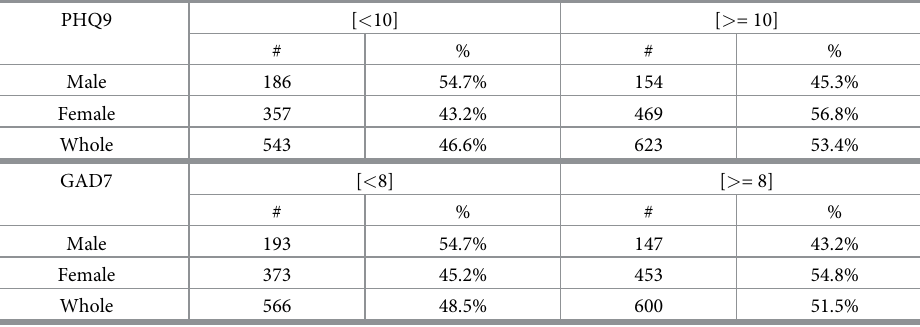
presented in Table 6. With respect to gender, female students had significantly higher levels of anxiety and depression and poorer overall self-rated health. Comparing scores for undergradu- ates and post-graduates, a statistically significant difference was found for the PHQ-9 (depres- sion) only, with undergraduates showing a higher level of depression. This is also reflected in a higher percentage of undergraduates scoring above the clinical cut off on the PHQ9 (56.4%) compared to post-graduates (51%), shown in Table 12. No significant differences were found Table 11. Distributions of PHQ9 and GAD7 based on clinical thresholds and